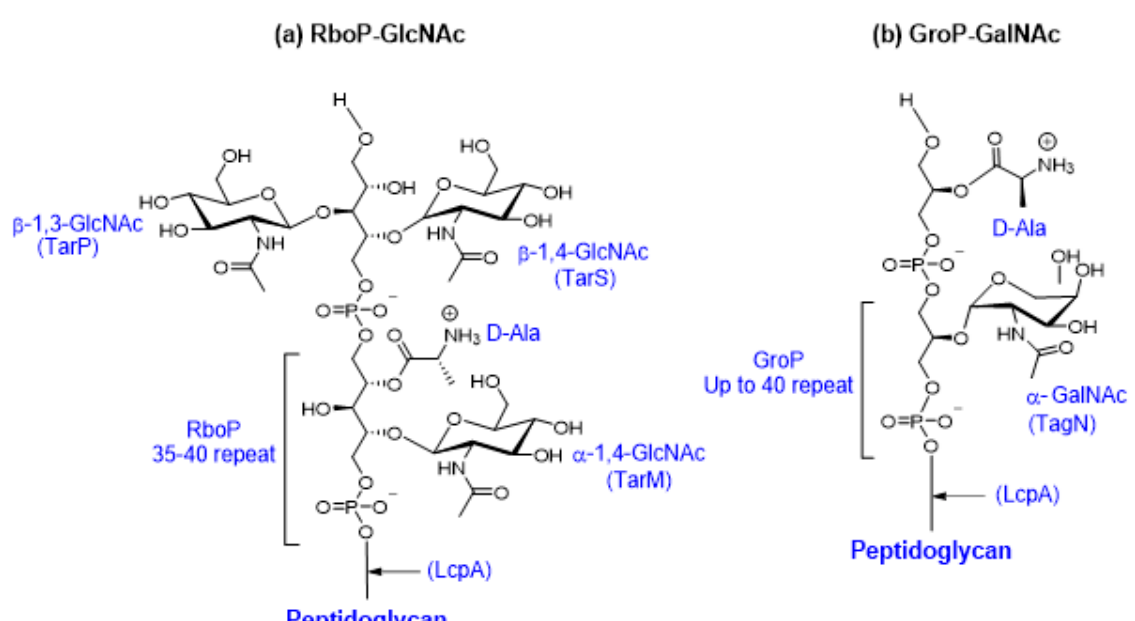
Figure 5. Structure of S. aureus wall teichoic acids (WTAs). ( a ) The ribitol-phosphate (RboP) WTA in the majority S. aureus lineages comprises a polymerized RboP backbone modified with α -1,4-GlcNAc, β -1,4-GlcNAc, β -1,3-GlcNAc, and D-alanine residues. ( b ) The glycerol-phosphate (GroP) WTA of the phylogenetically isolated S. aureus ST395 lineage comprises a polymerized GroP backbone, modified with α‐ linked GalNAc by the glycosyltransferase TagN.